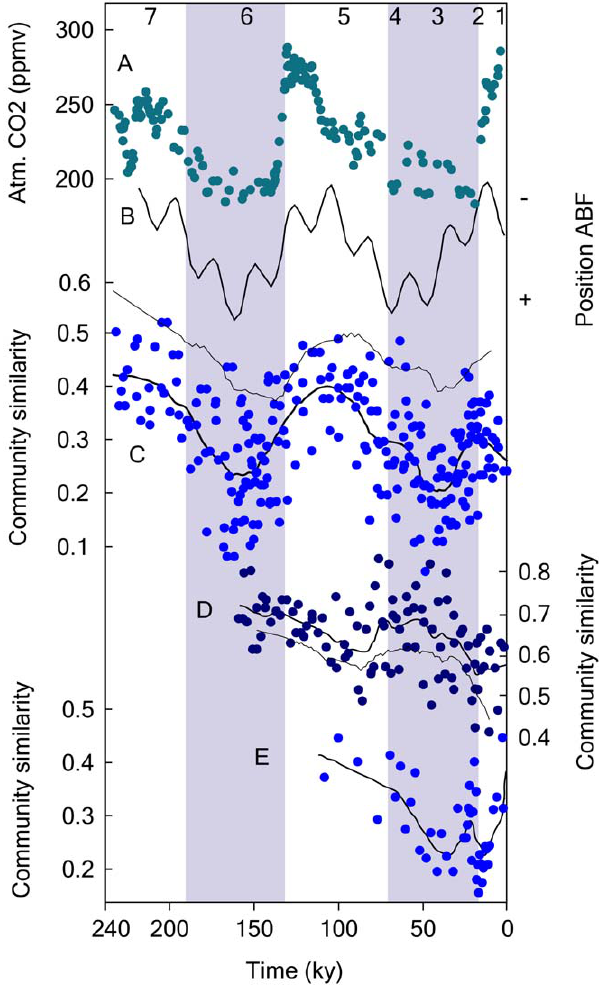
Figure 4. Response of marine diatom communities to past climate change. A. Changes in atmospheric CO 2 concentration from Vostok ice core [12]. B. Position of the Angola-Benguela front (ABF) indicating variations in the strength of the upwelling [51]. C–E. Jaccard similarity index comparing community composition at each time with the earliest communities of the record in the Walvis basin, SW Africa (GeoB1710), the Eastern Equatorial Atlantic (M16772-2), and the Mauritanian upwelling system (M12392), respectively. Each point is a pair-wise comparison between pair of communities separated in time. Thick and thin lines are the average trend of community similarity calculated using the Jaccard index and the Bray-Curtis quantitative index, respectively. The analysis shows cycles of community departure and recovery. Lower similarity values correspond with comparisons between communities from different climatic periods, and viceversa. Numbers at the top are oxygen isotopic stages. Shaded areas represent glacial